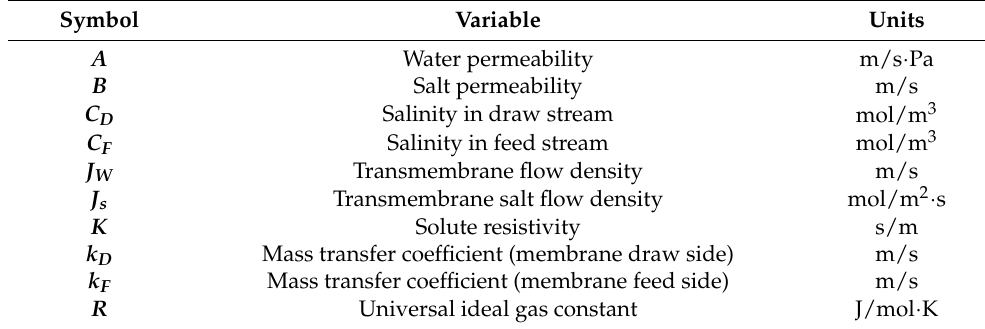
Figure 2. ( A ) Location of the study zone and domain of the first mesh of the model. The dashed square shows the simulation domain of the nested and more refined model. ( B ) Details of the covered area and bathymetry of the nested model. Table 1. List of